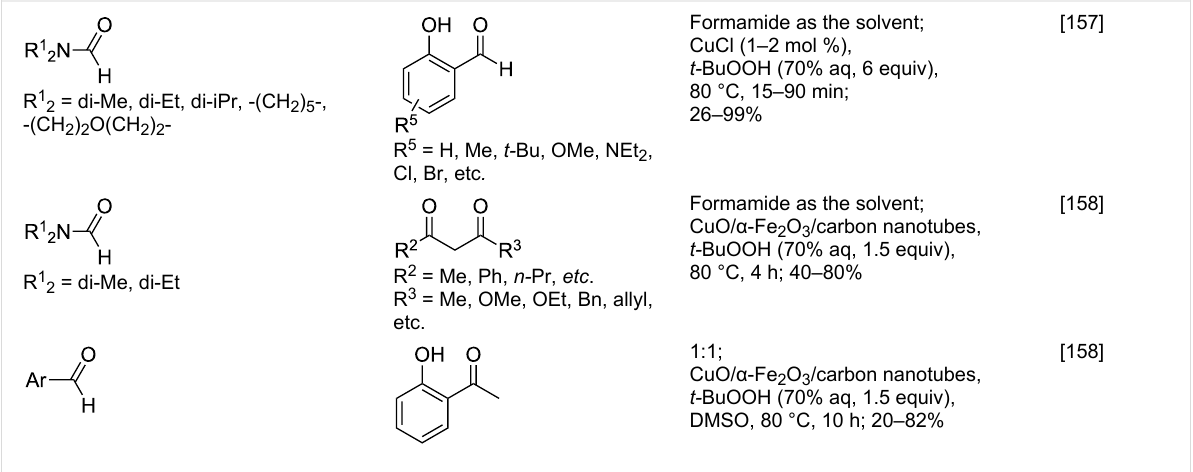
Table 5: Oxidative coupling of alcohols, aldehydes, or formamides with 1,3-dicarbonyl compounds or phenols in the presence of tert -butyl hydroper- oxide and copper salts. (continued)